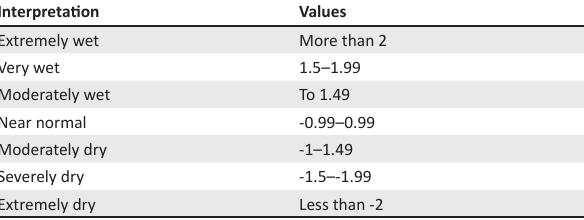
TABLE 2 : Standardised precipitation index interpretation table. Interpretation Values Extremely